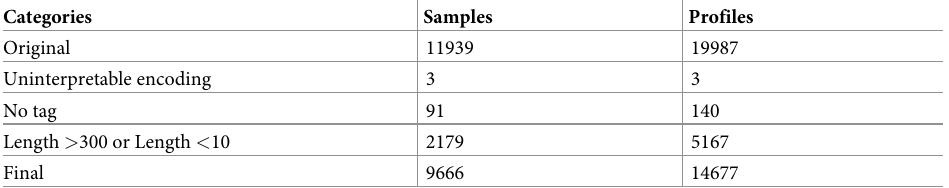
Table 3. Sample and profile